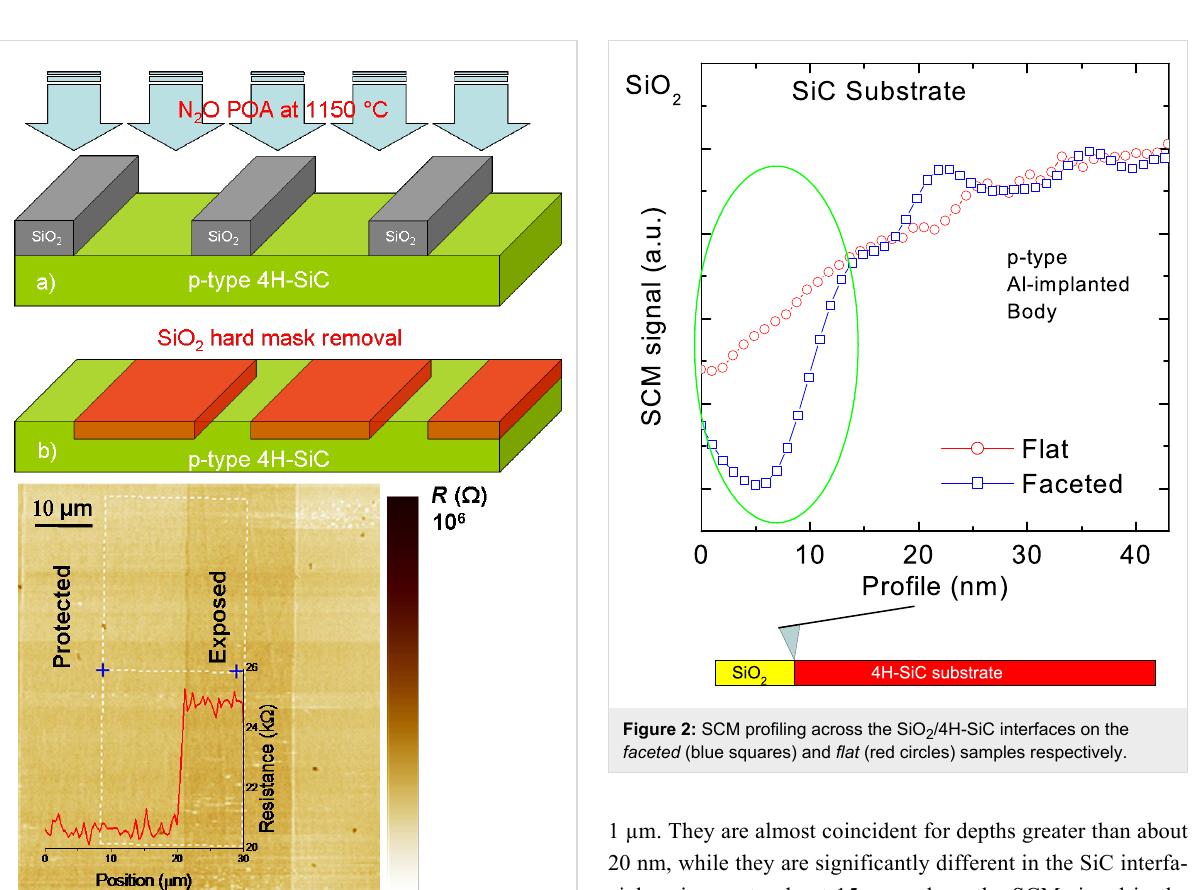
1 µm. They are almost coincident for depths greater than about 20 nm, while they are significantly different in the SiC interfa- cial region up to about 15 nm, where the SCM signal in the faceted sample is lower than in the flat sample. The lower SCM signal indicates a higher compensation of Al acceptors, which is consistent with a more efficient incorporation of